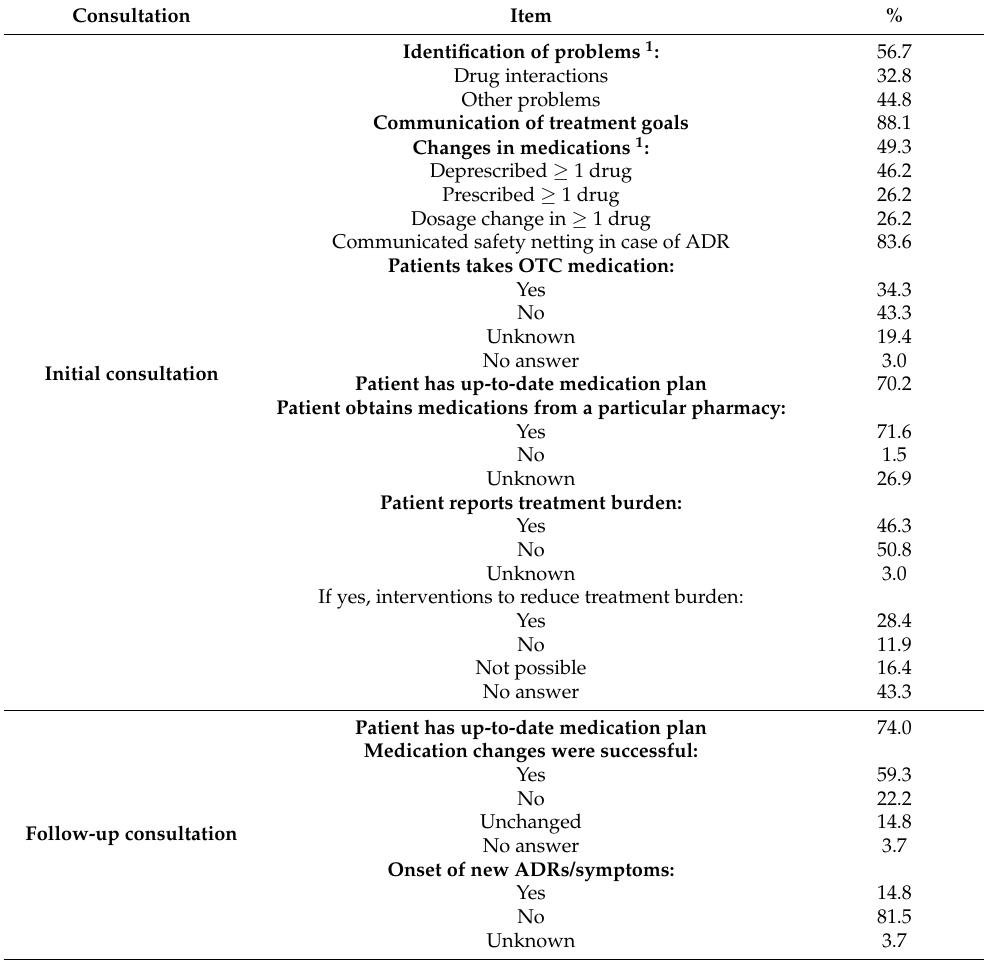
Table 4. Results from the feasibility